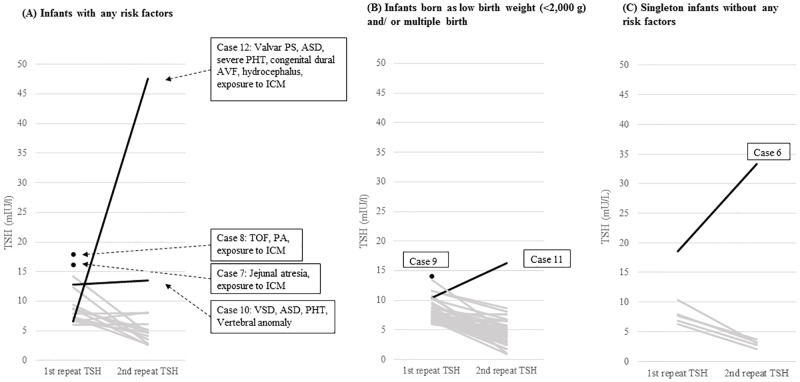
Changes in thyroid stimulating hormone (TSH) levels among 68 neonates with venous TSH levels of 6–20 mU/L at the first repeat test.(A) Infants with any risk factors (n = 20); (B) infants born at low birth weight and/or as a multiple birth without other risk factors (n = 42); and (C) singleton infants without any risk factors (n = 6) (four black lines indicate those starting levothyroxine after the second repeat test, three black spots indicate those starting levothyroxine after the first repeat test, and 61 gray lines indicate no treatment).